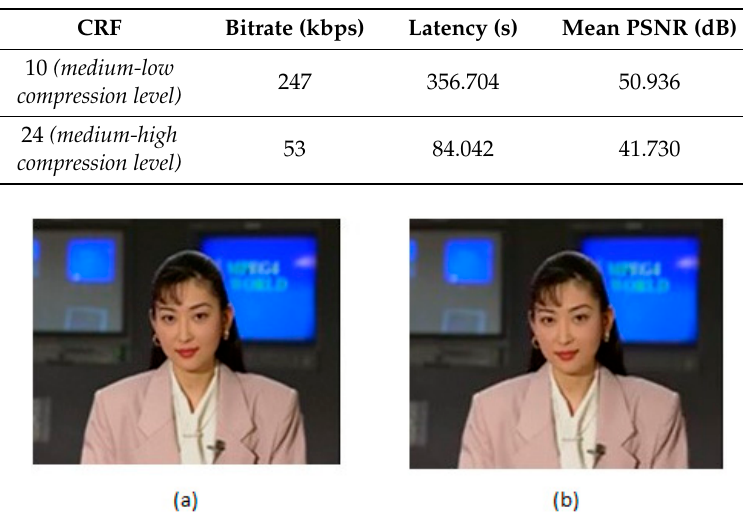
Figure 1 . ( a ) Akiyo QCIF, CRF = 10; ( b ) Akiyo QCIF, CRF = 24. Figure 1. ( a ) Akiyo QCIF, CRF = 10; ( b ) Akiyo QCIF, CRF =